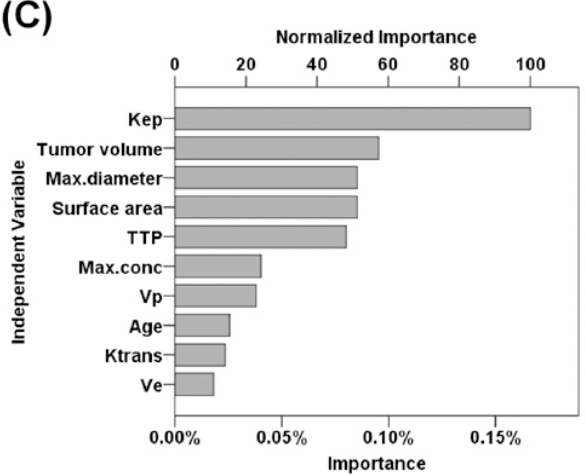
Figure 2. Performance of predictive parameters using variable importance analysis. ( A ) Parameters for predicting PMT subtypes. ( B ) Parameters for predicting Hodgkin lymphoma. ( C ) Parameters for predicting invasive thymoma. Abbreviations: EES = extravascular extracellular space; K trans = efflux rate constant from blood plasma into the tissue EES; K ep = the efflux rate constant from tissue EES into the blood plasma; V e = EES volume per unit of tissue; V p = blood plasma volume per unit volume of tissue; TTP = time to peak of the concentration curve.